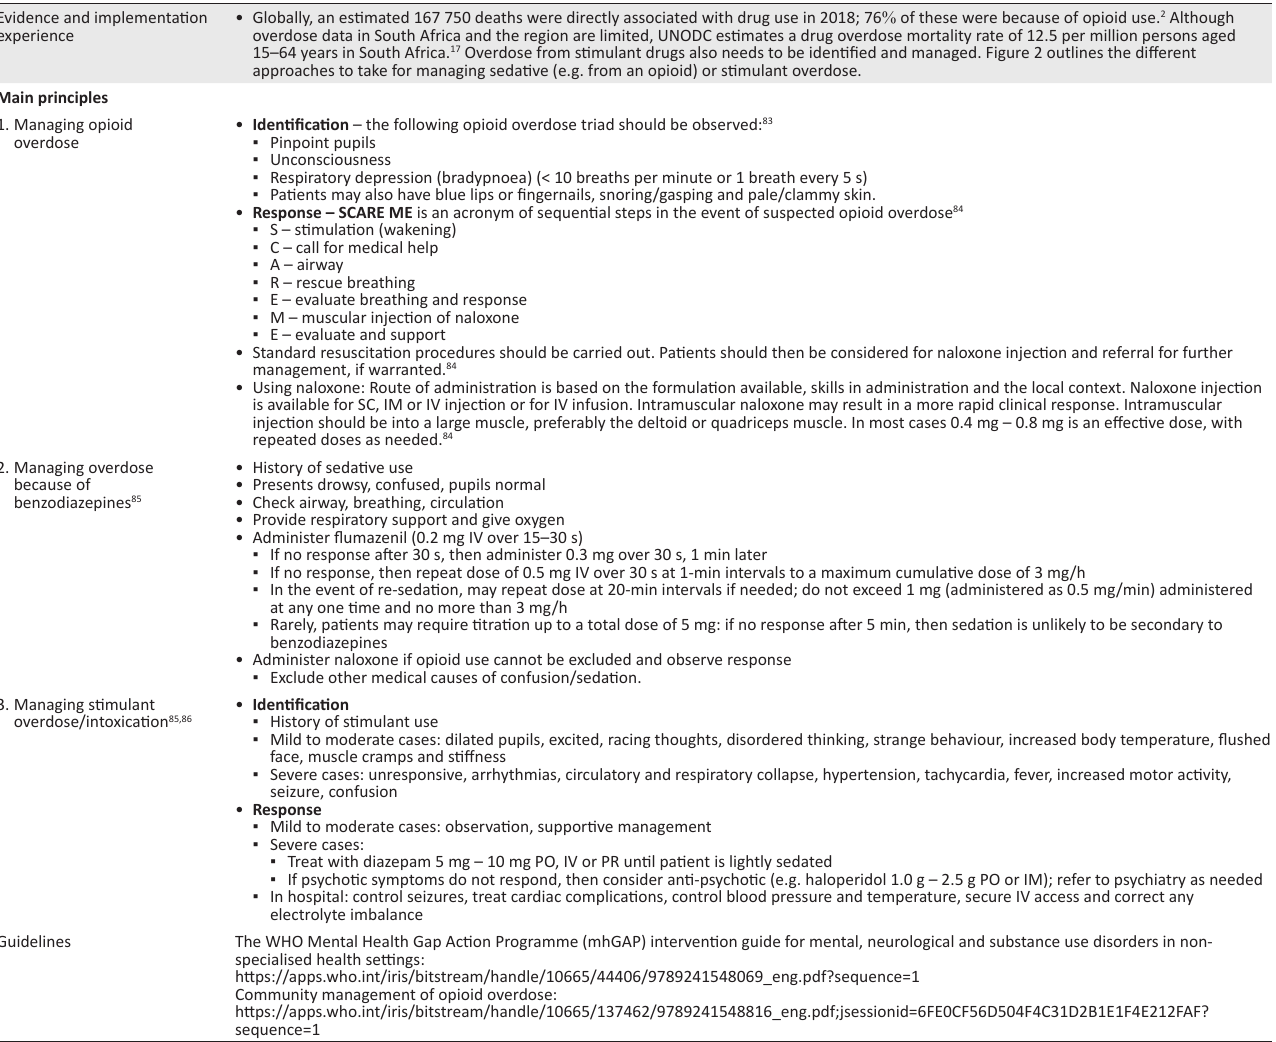
TABLE 17: Harm reduction interventions – Overdose services. 83,84,85 Variable